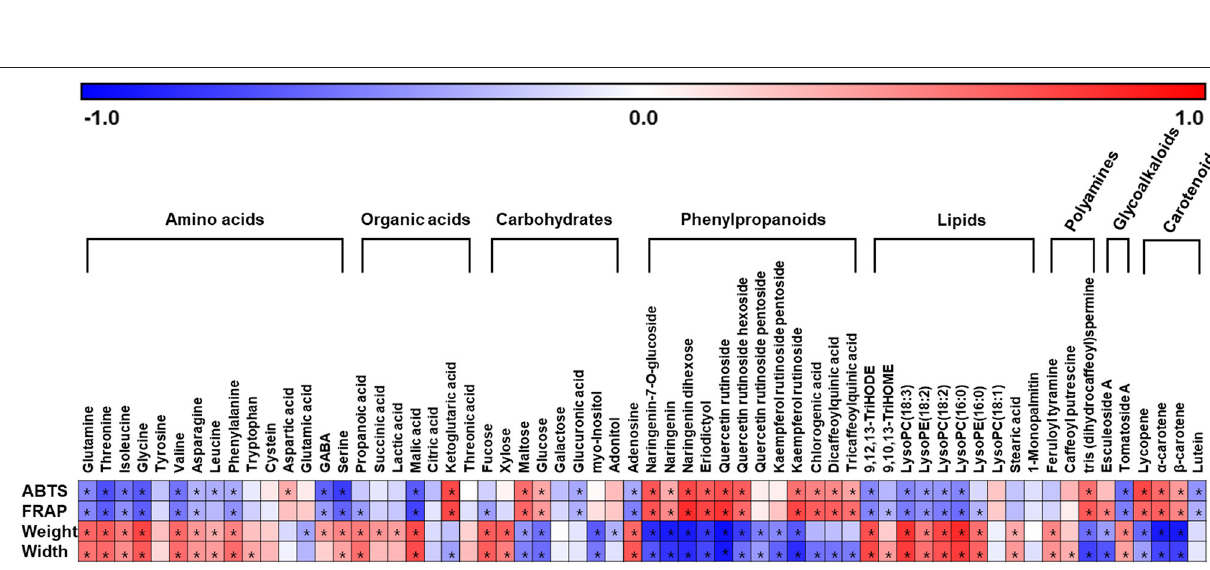
FIGURE 5 | Correlation map between the metabolite levels and observed ABTS, FRAP, weight, and width in five types of tomato. Each metabolite is identified as significantly different metabolites through PLS-DA model ( Supplementary Figure 1 ). Each square implies Pearson’s correlation coefficient between metabolites and assayed activities. The red color indicates a positive (0 < r < 1) correlation, and the blue colors indicate a negative ( − 1 < r < 0) correlation. Asterisks indicate p- values < 0.05. ABTS, 2,2 ′ -azinobis (3-ethylbenzothiazoline-6-sulfonic acid) diammonium salt; FRAP, ferric reducing antioxidant power; PLS-DA, partial least squares-discriminant